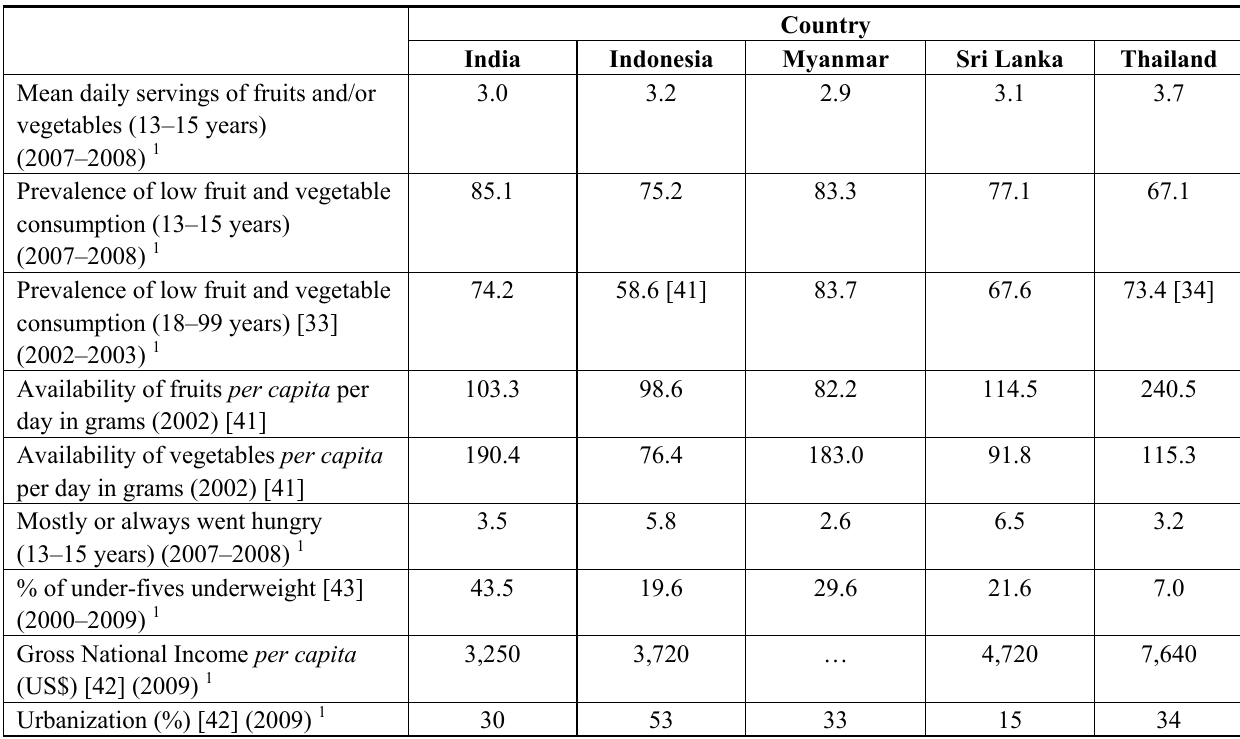
Table 4. Country comparison of fruits and vegetable consumption and associated indicators, GSHS